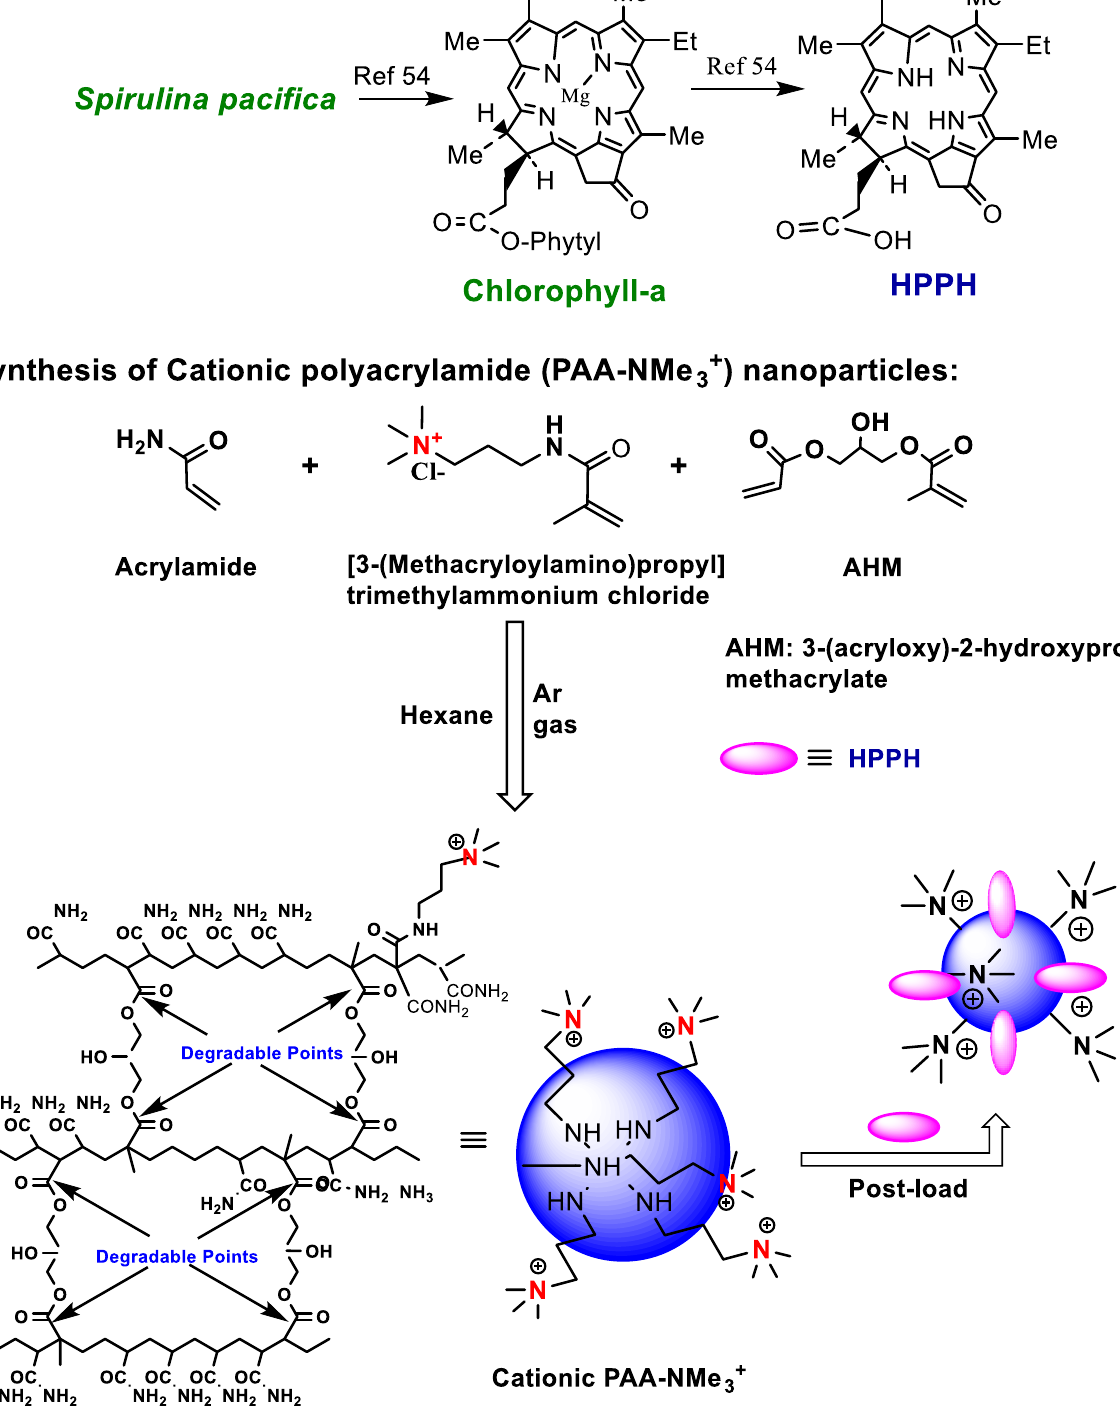
Figure 1. Synthesis of cationic polyacrylamide (PAA-NMe 3+ ) nanoparticles post-loaded with